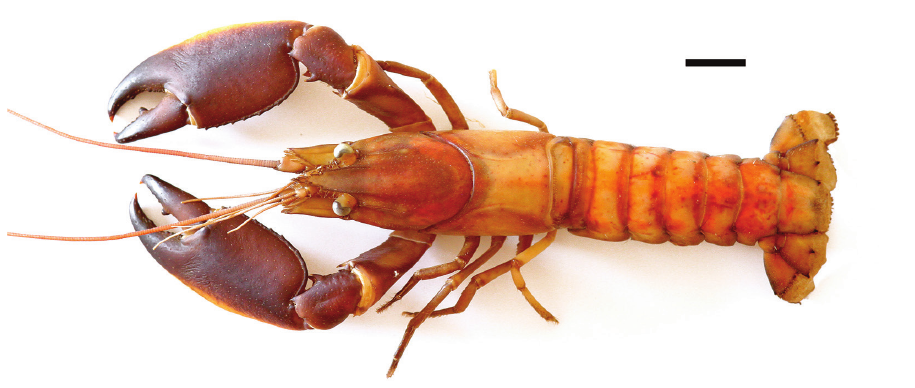
Figure 2. Cherax warsamsonicus sp. n. holotype male (MZB Cru 4529). Scale bar: 10